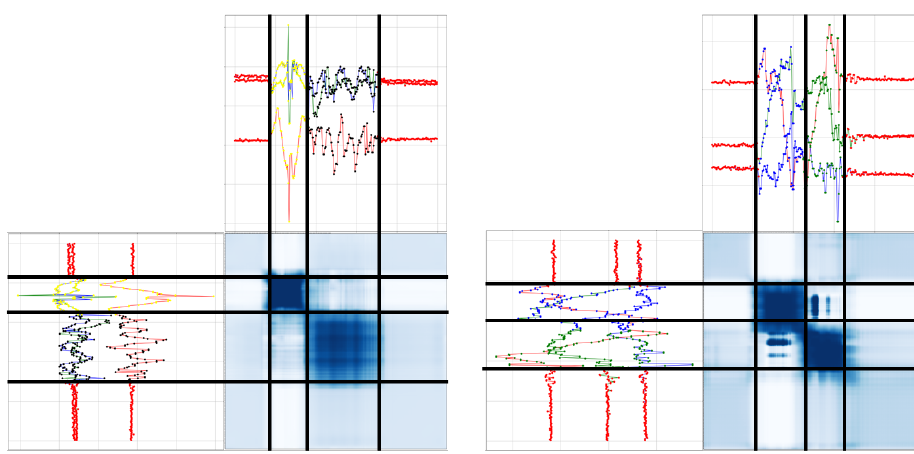
Figure 6. Examples of attention score in spatial level.